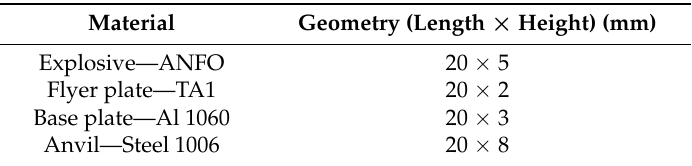
Table 1. Geometry parameters of two-layer plates, explosive, and anvil used in the model (ANFO: Ammonium-nitrate/fuel-oil).